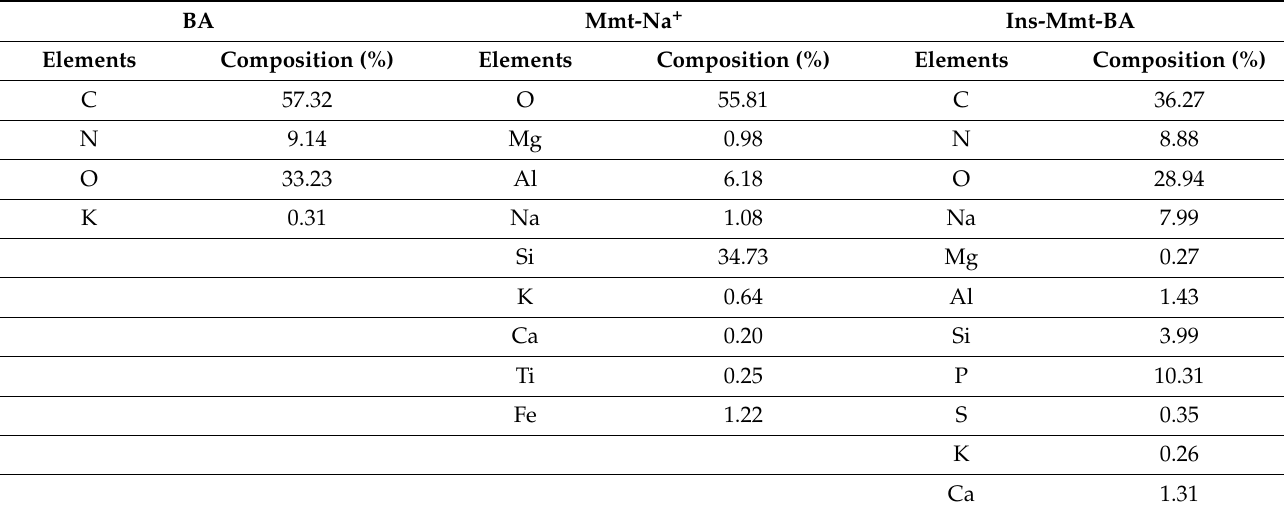
Figure 6. EDS spectra of BA hydrogel, Mmt-Na + clay and Ins-Mmt-BA hydrogel NC. Table 3. Comparative elemental composition (%) of BA hydrogel, Mmt-Na + and Ins-Mmt-BA hydrogel